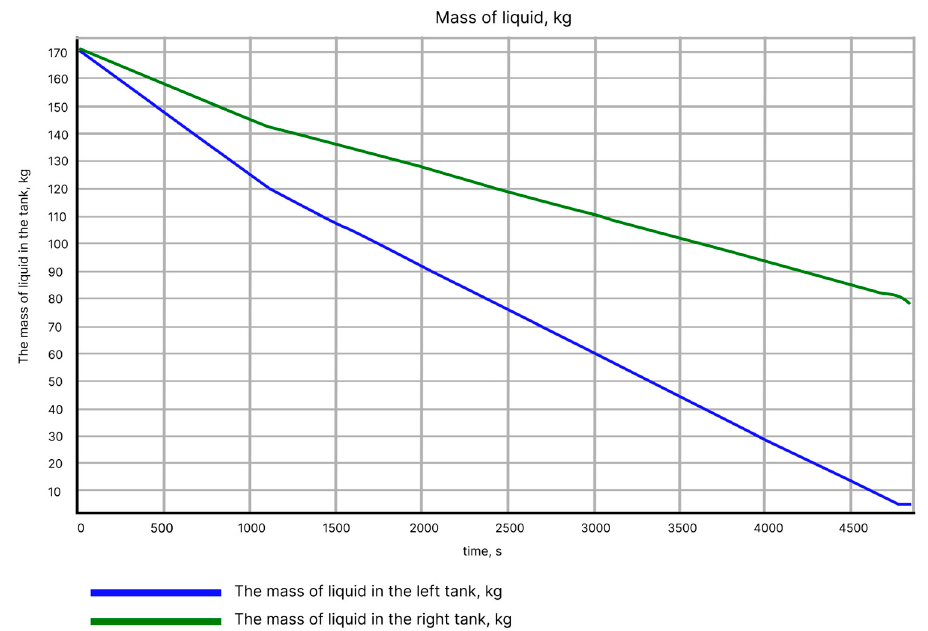
Table 1. Simulation data.